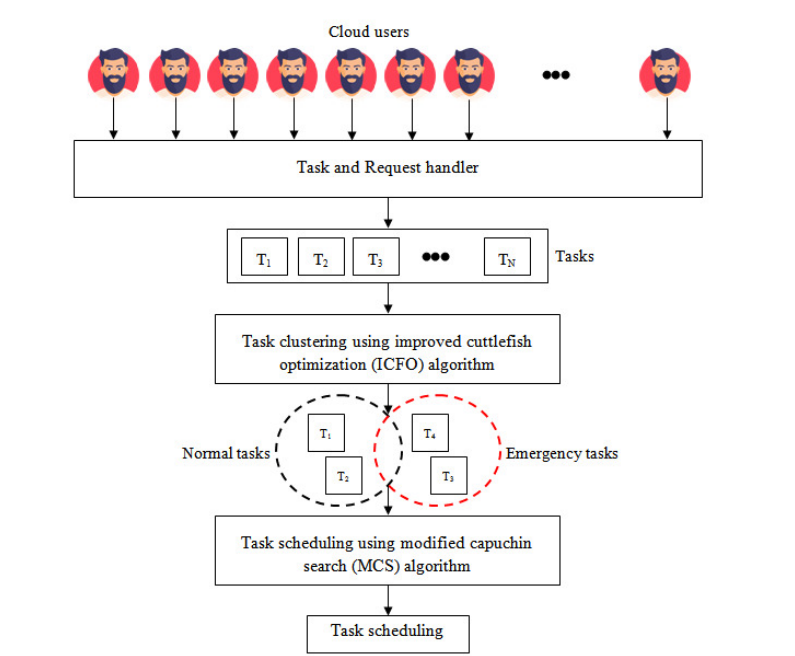
Figure 1. Proposed system model for CSTS method.